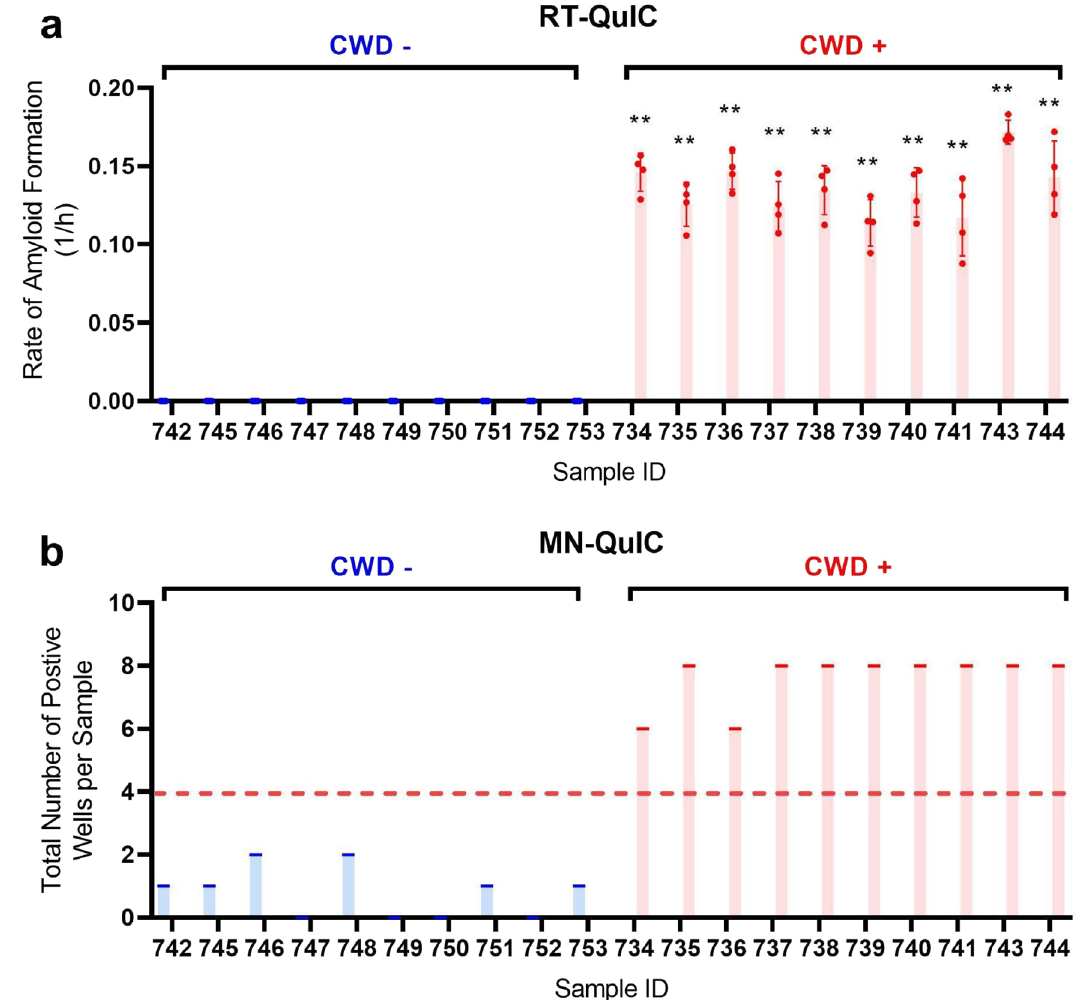
Figure 6. Comparison of RT-QuIC and MN-QuIC results for CWD positive and negative palatine tonsil tissues. MNPRO sample process identification number on horizontal axes ( a ). Fluorescent RT-QuIC data for tissues (see Supplementary Table S4) used in ( b ). ( b ) MN-QuIC data for tonsil samples used in this study. Number of red wells out of the 8 replicates for each sample tested. Following published RT-QuIC protocols (see Results and discussion) 50% or more of MN-QuIC red wells are identified as CWD positive and less than 50% of MN-QuIC red wells as CWD not detected or negative. **p < 0.01, error bars show standard deviation.